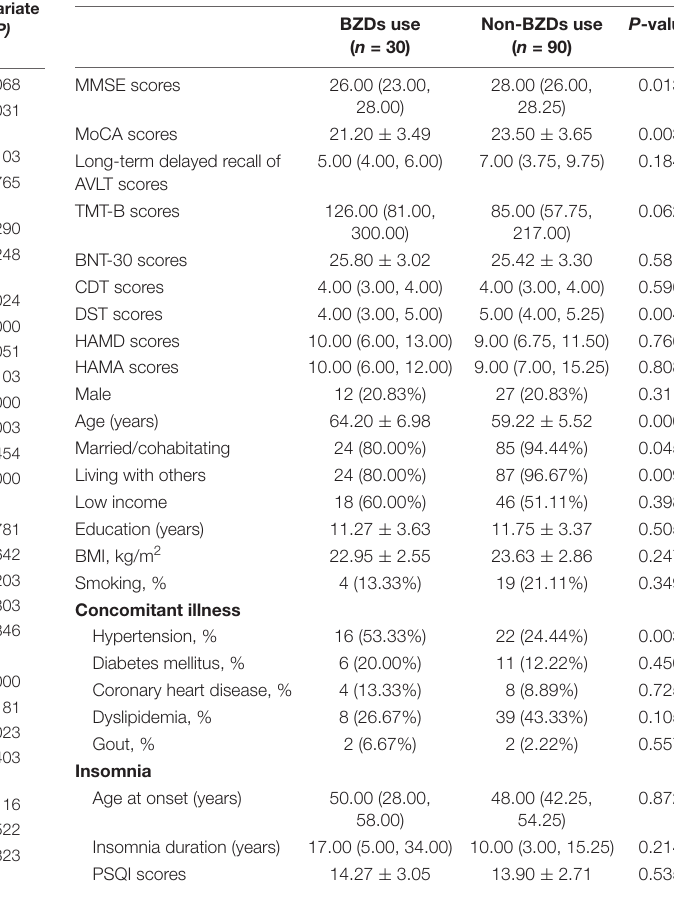
TABLE 3 | Univariate analysis for factors associated with cognition in benzodiazepines and Z-drugs use patients.